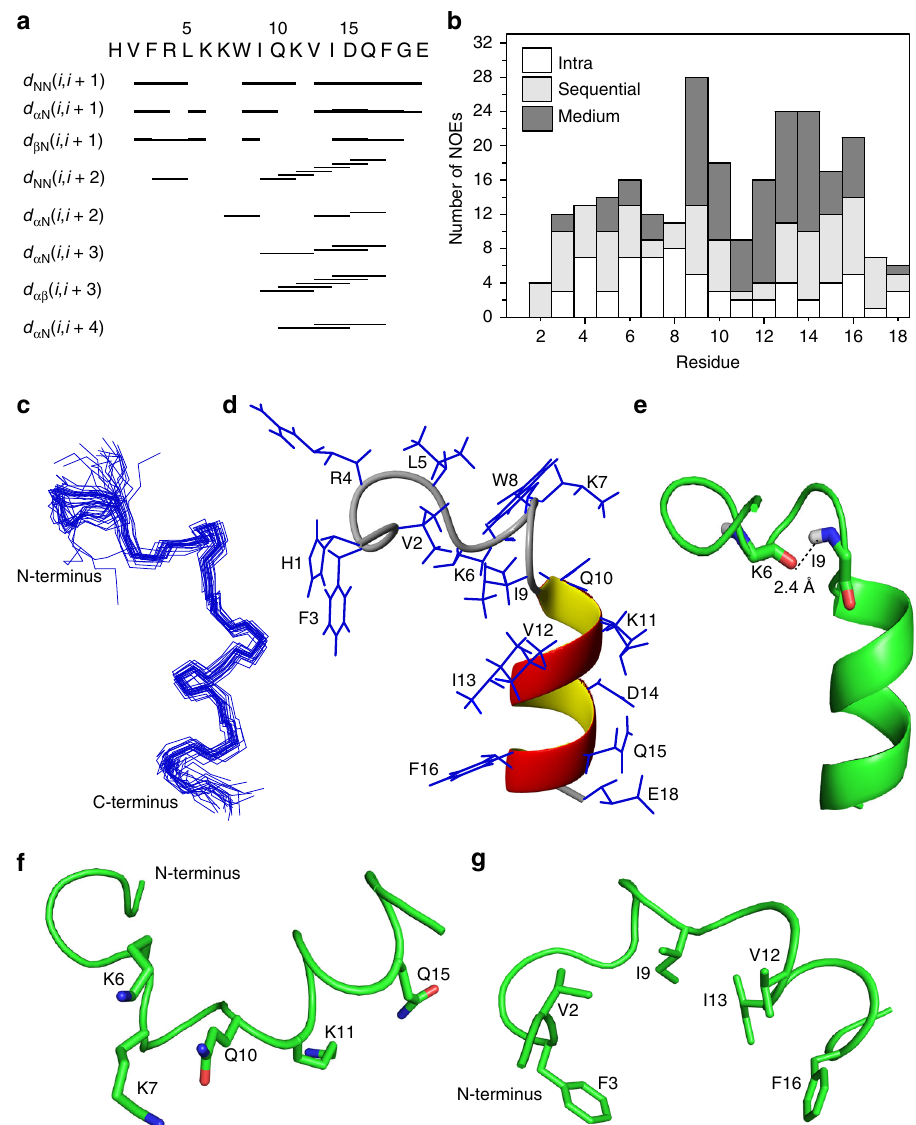
Fig. 4 Analyses of tr-NOESY spectrum and three-dimensional solution structure of HVF18 in LPS micelles. a Diagram summarising the sequential and medium range NOE contacts identi fi ed in HVF18. b Bar diagram showing number and type of NOEs observed for HVF18 in complex with LPS as a function of amino acids. c Superposition of backbone atoms (N, C α , C ’ ) for the 20 lowest energy conformers of LPS-bound HVF18. d A representative structure of LPS-bound HVF18 showing backbone topology and side-chain dispositions and ( e ) plausible hydrogen bond formation between K6 and I9 in the β -turn region. Ribbon representation of peptide backbone showing amphipathic disposition of ( f ) hydrophilic residues along the convex side ( g ) and the hydrophobic residues on the concave side of a curved backbone fold of HVF18 in complex with LPS. Figures were generated using MolMol v2K.2 and Pymol